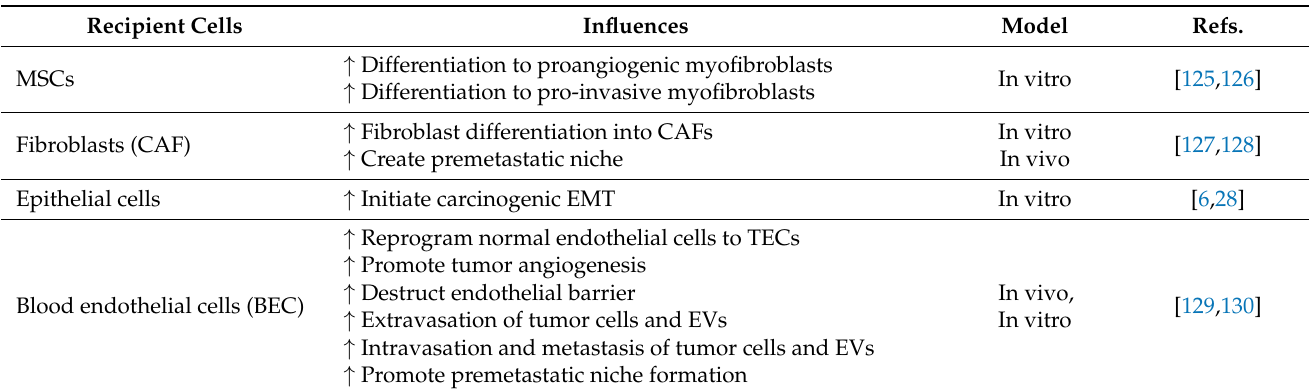
Figure 2. Cancer cell-derived EVs affect various cell types in the tumor microenvironment. Cancer EVs play crucial roles in immunosuppression, immune evasion, apoptosis of immune cells, and im- munotherapy resistance. Thus, cancer EVs change hot tumors into cold ones. Moreover, cancer EVs affect nonimmune cells, including cellular transformation (including EMT), chemoresistance, tumor matrix production, destruction of biological barriers, angiogenesis, lymphangiogenesis, and pro-/premetastatic niche (PMN) formation. Table 3. Influences of cancer cell-derived EVs on recipient cells.